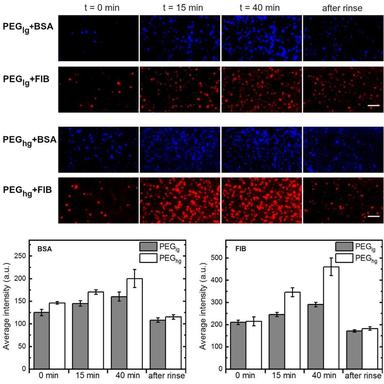
Representative TIRF micrographs during protein adsorption experiments on PEG surfaces (top). Scale bar = 5 μm. Average intensity of fluorescently labeled protein in the TIRF microscopy images (bottom). The error bars represent standard deviations (n = 3 independent experiments for each condition).